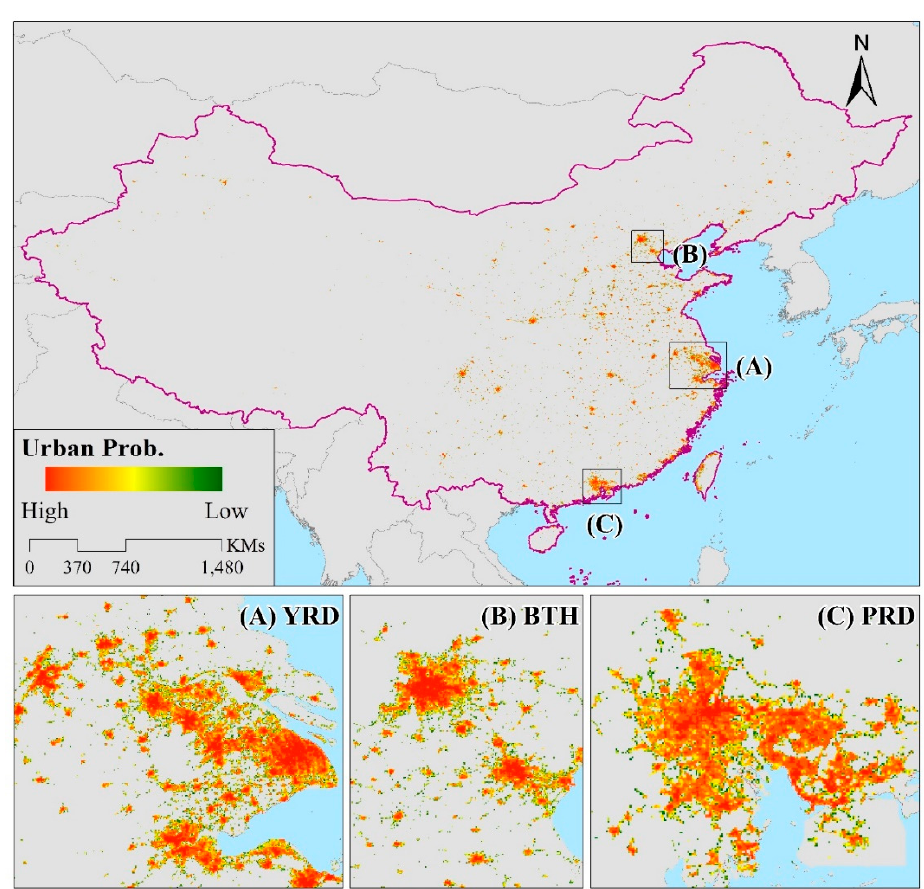
Figure 7. The probability (Prob.) of urban area extraction using the random forest classifier. A, B, and C show the result for the Yangtze River Delta (YRD), Beijing–Tianjin–Hebei (BTH), and Pearl River Delta (PRD) regions, respectively.